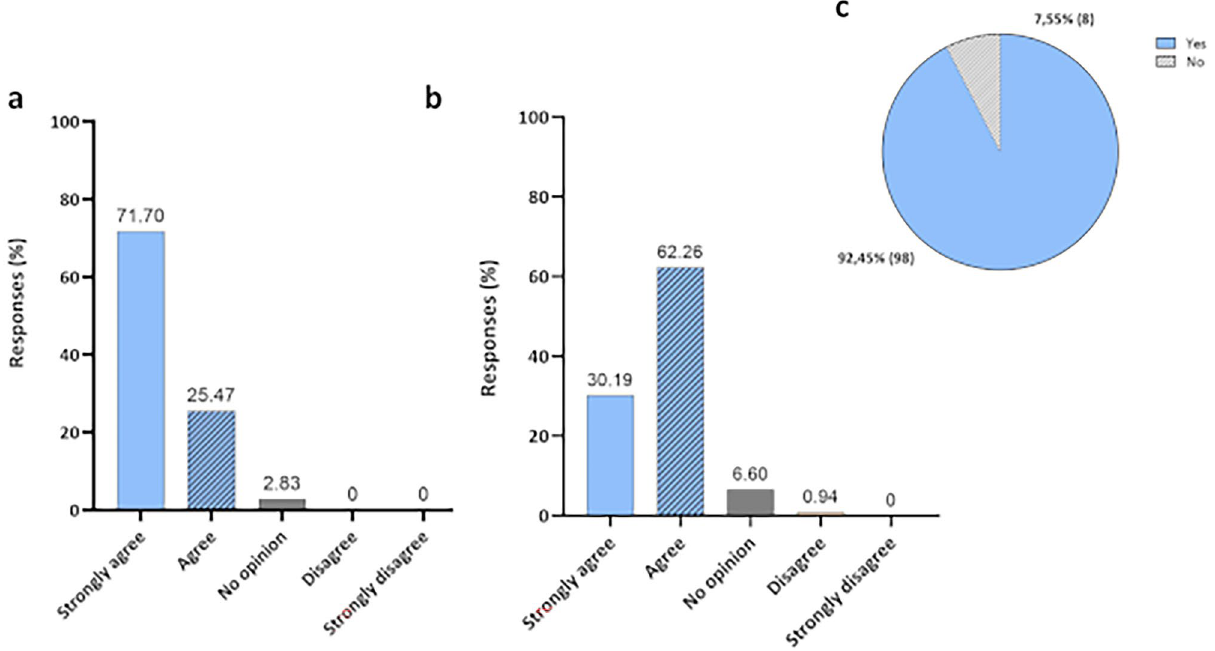
Figure 9. Participants’ opinions. ( a ) Even with the use of the chamber, all personal hygiene procedures must be strictly followed; ( b ) the use of the disinfection chamber with ozonized water can be a safe alternative for surface disinfection; and ( c ) percentage approval of the disinfection technology used by study